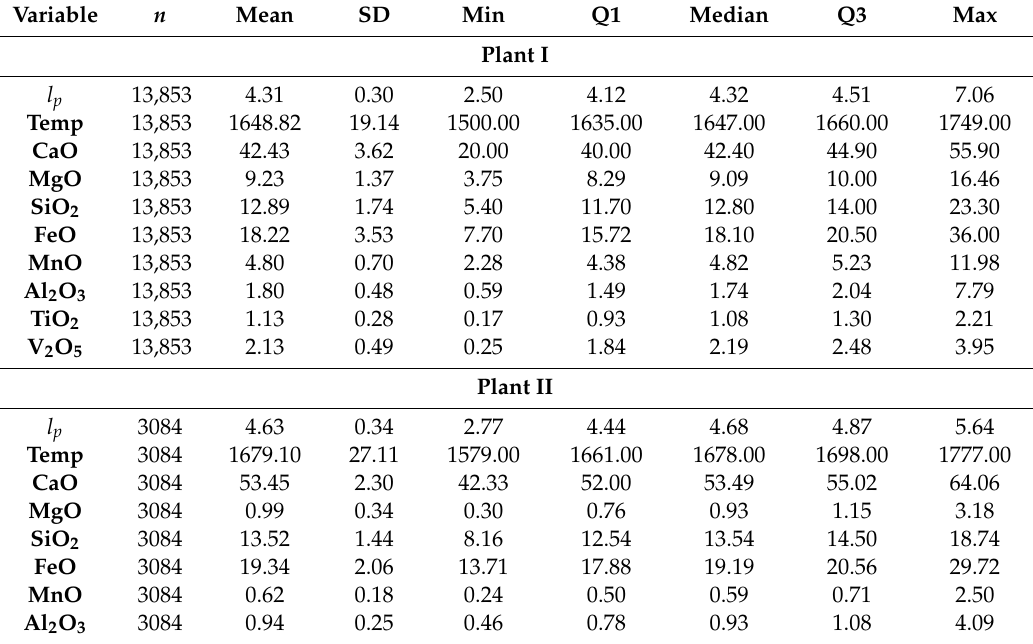
Table 1. Descriptive statistics of all variables taken for analysis from plant I and plant